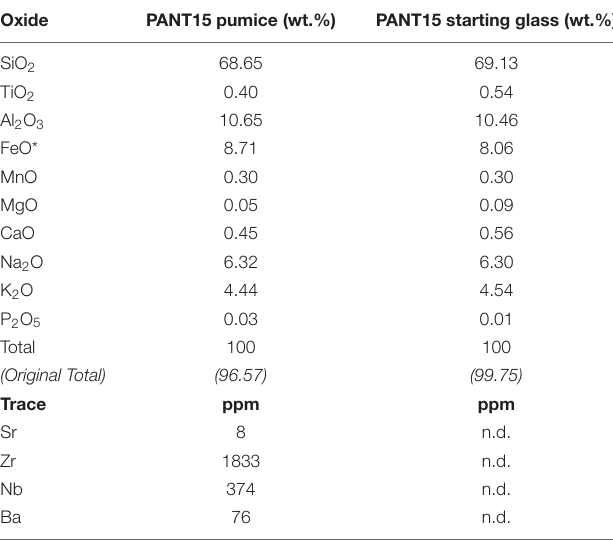
TABLE 1 | Bulk compositions of Cuddia del Gallo pumice (PANT 15, Gioncada and Landi, 2010) and of the molten pumice (starting glass). Oxide PANT15 pumice (wt.%) PANT15 starting glass